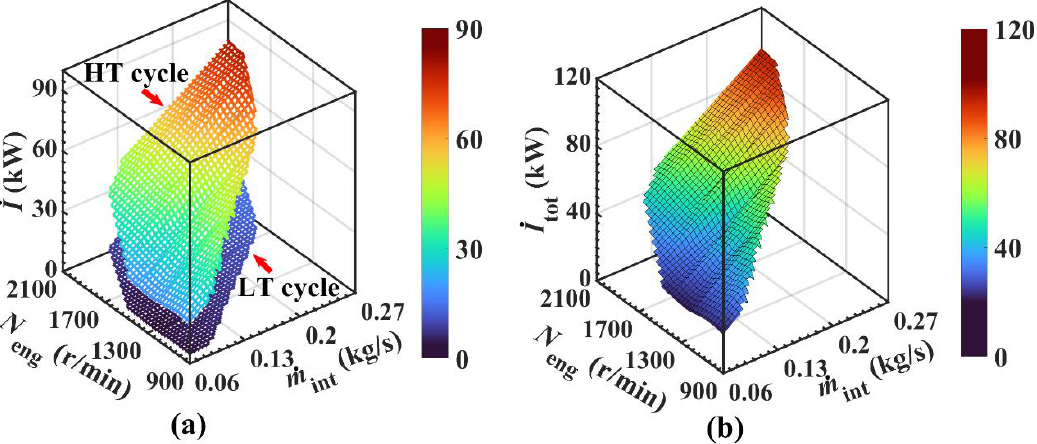
Figure 14. Exergy destruction of HT cycle, LT cycle and the system under variable working condi- tions. (a) Exergy destruction characteristics of different cycles. (b) System exergy destruction char- acteristics.